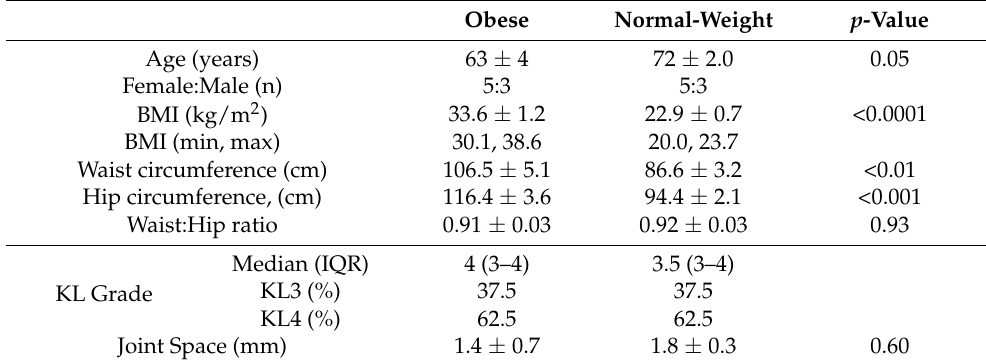
Table 1. Characteristics of the patient participants for the NMR spectroscopy. Obese Normal-Weight p -Value Age